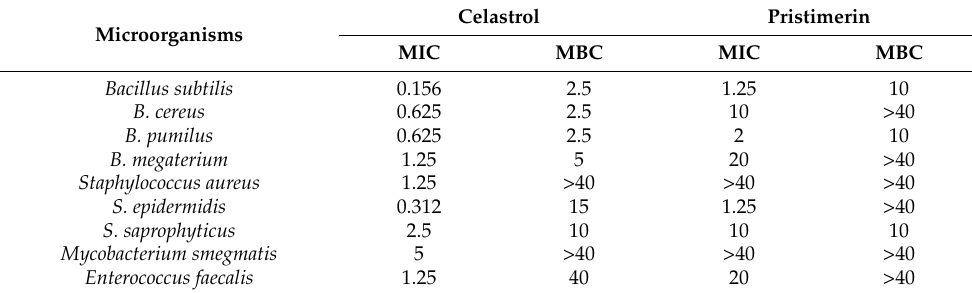
Table 1. Minimum inhibitory concentration (MIC) 1 and minimum bactericidal concentration (MBC) 1 of celastrol and pristimerin, expressed in µ g/mL against different microorganisms 2